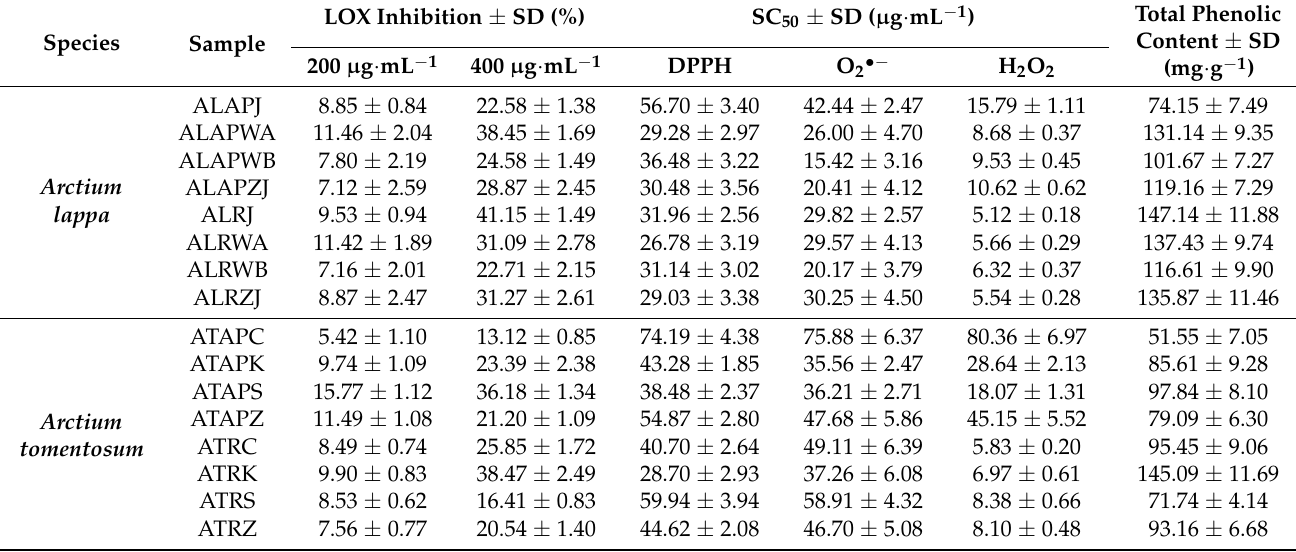
Table 2. Inhibition of lipoxygenase (LOX) activity, SC 50 (extract concentration required to scavenge 50% of the radical) values of scavenging of DPPH, superoxide anion, and hydrogen peroxide, as well as total phenolic content in the tested